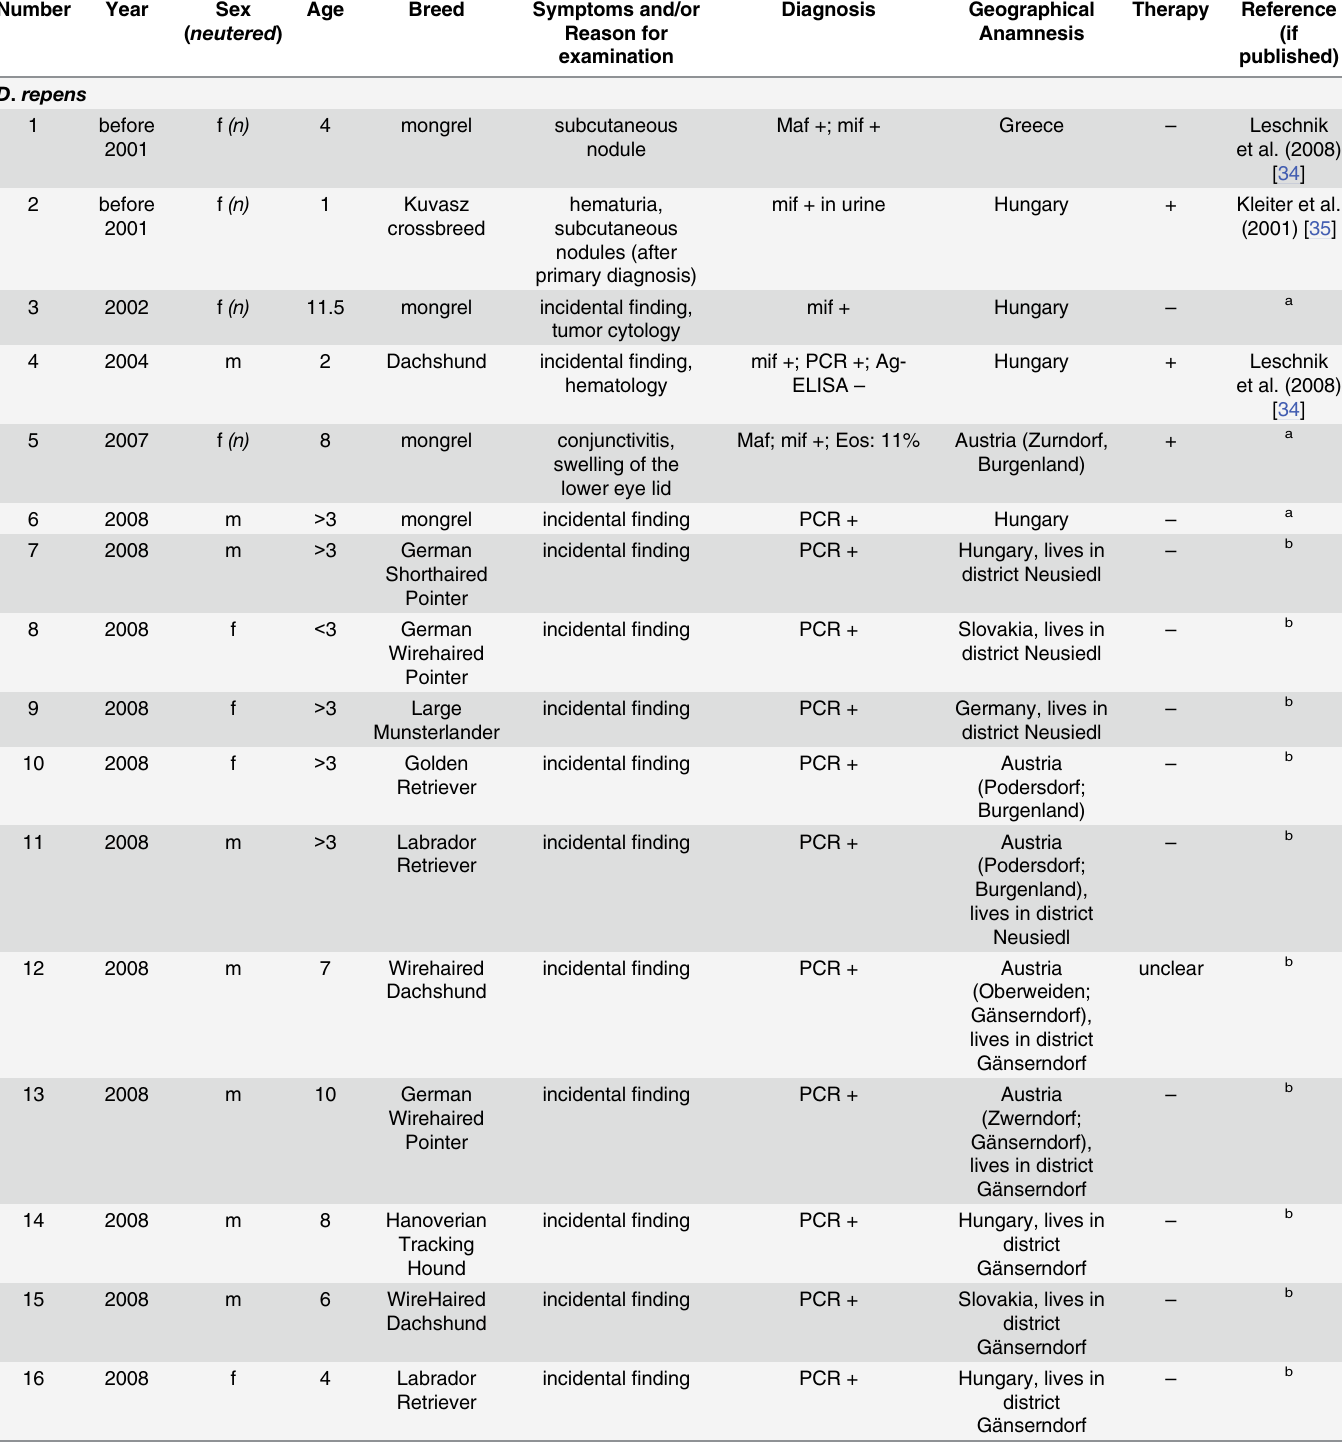
Table 3. Documented cases of Dirofilaria repens and Dirofilaria immitis in dogs in Austria. +: positive; – : negative; nd: not determined; His: Histology; Ser: Serology; Maf: microfilariae (adult stage); mif: microfilariae (first larval stage) in blood, if not specified otherwise; Eos: eosinophils; IgE: immunoglobulin E; Ag-ELISA: SNAP Canine Heartworm Antigen Test Kit (IDEXX